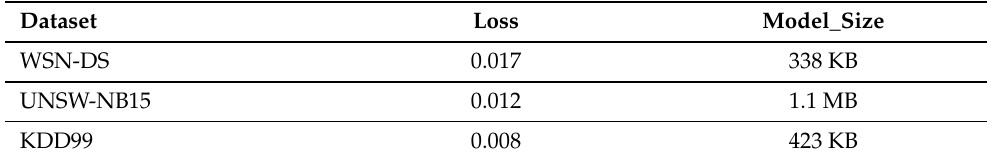
Table 5. Loss and model size information.